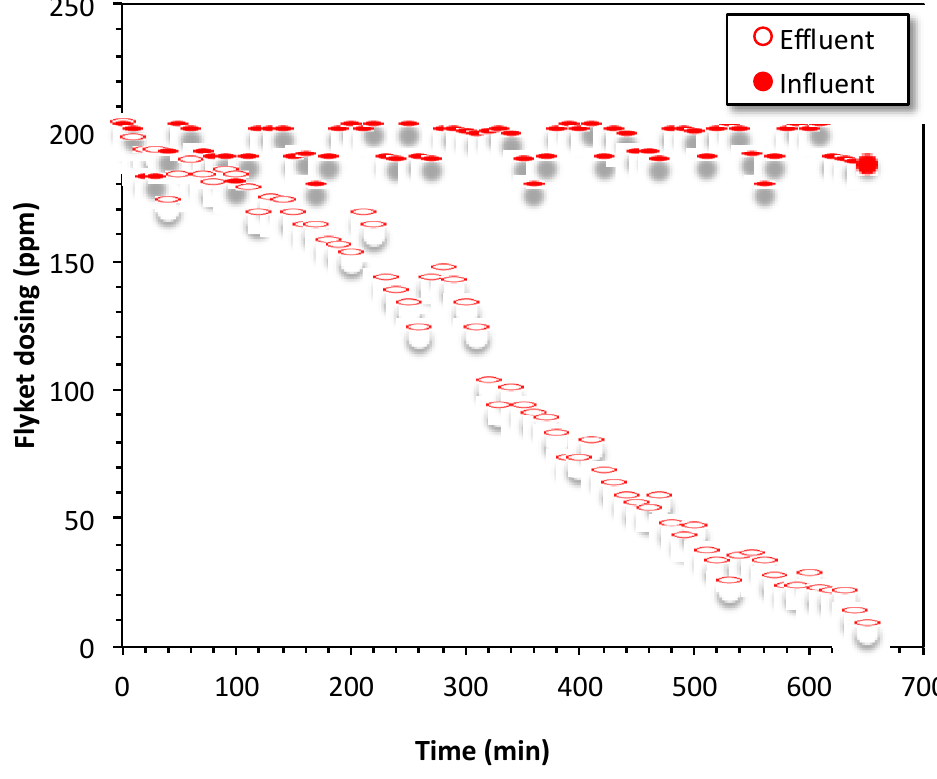
Figure 5. Time plot for the constructed alum sludge wetland trend in the system.